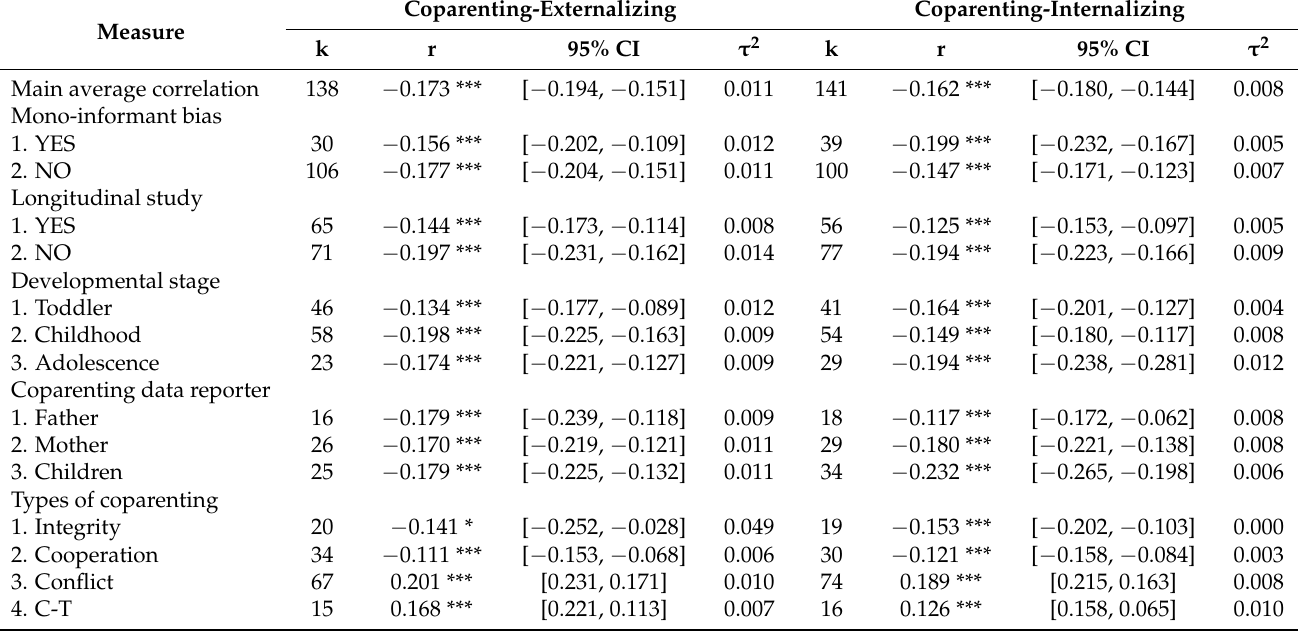
Table 1. Correlations between coparenting and externalizing and internalizing